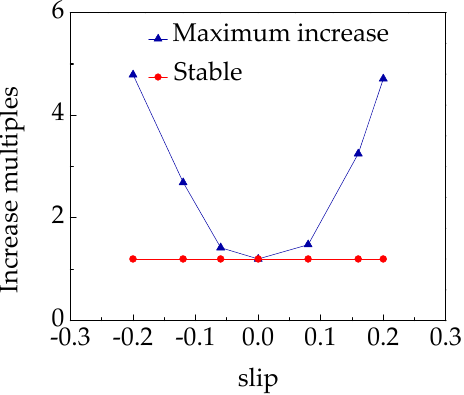
Figure 10. The increase multiples of the stator current after the three phase short-circuit loss of excitation.